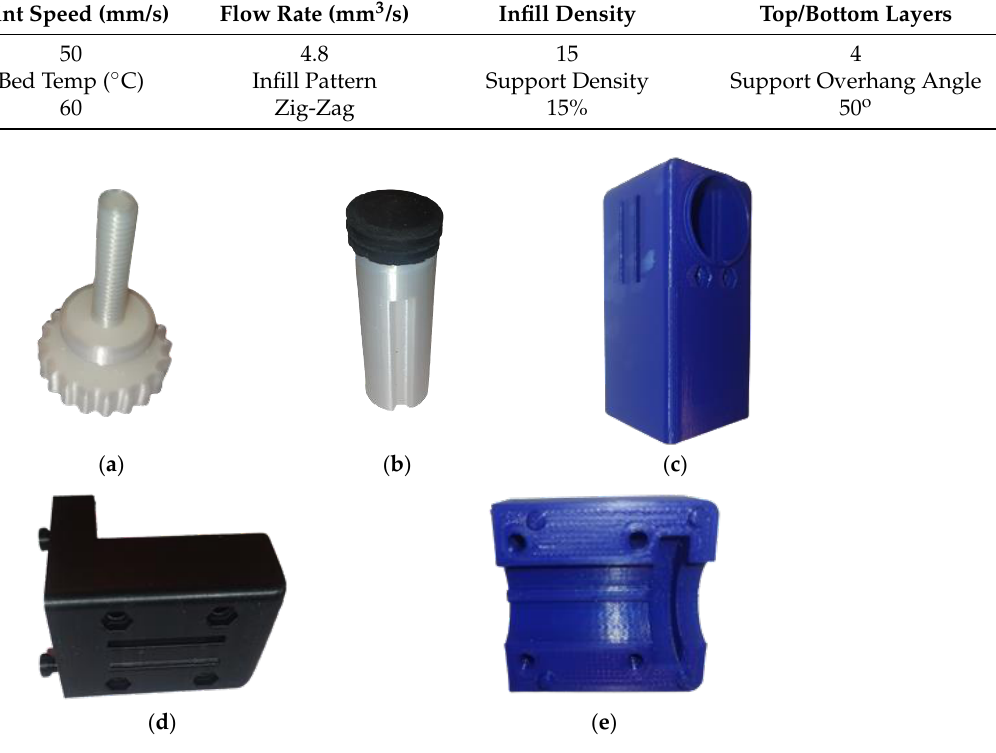
Figure 8. Physical illustration of: ( a ) Rotating Lever; ( b ) Piston with seal; ( c ) Shell; ( d ) Shell Connec- tion; ( e ) Shell Split.